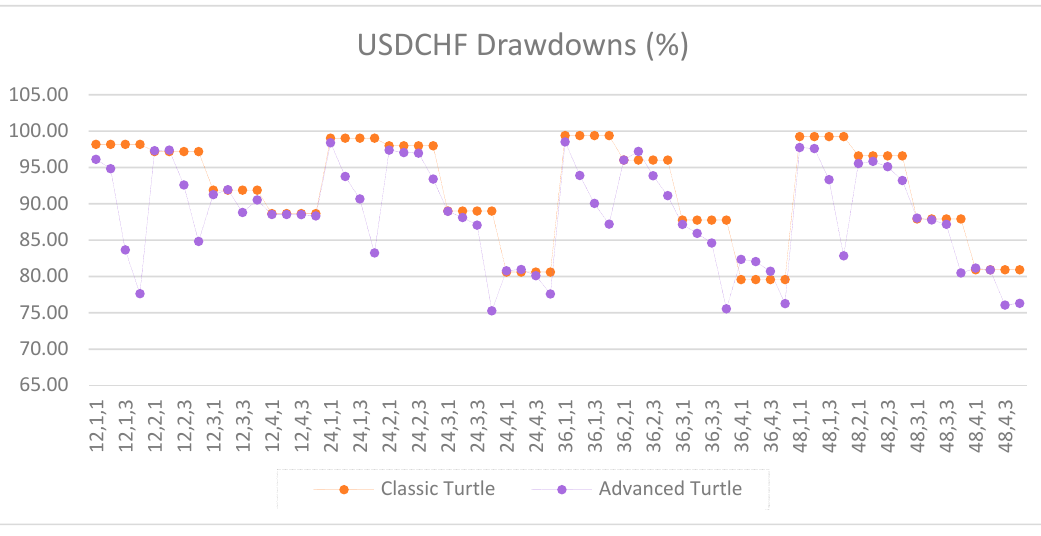
Figure A8. Drawdowns of USDCHF as percentage of equity between the classic and the advanced Turtle systems for every combination of N, X, Y for the fast parameters (20, 40).